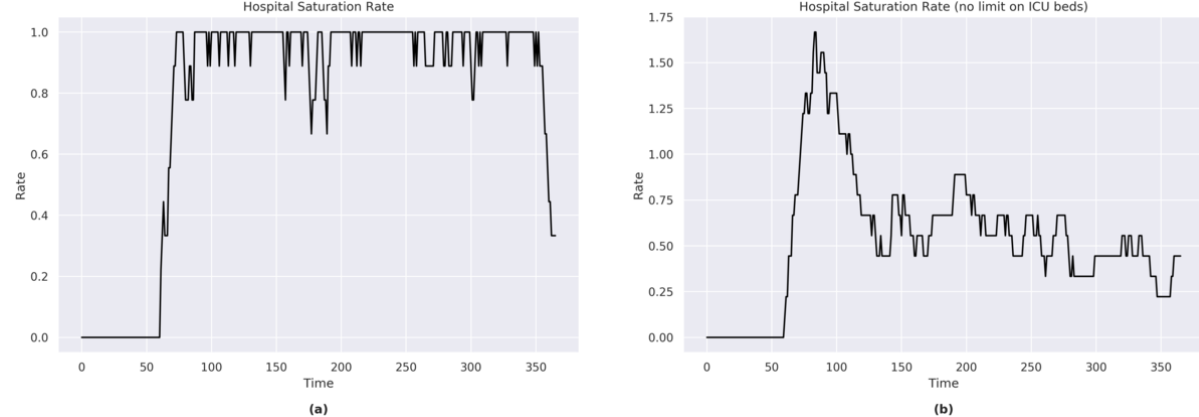
Figure 9. (a) Hospital saturation rate for Brazil. (b) Hospital saturation rate for Brazil (with no limit on the number of ICU beds). ICU: intensive care